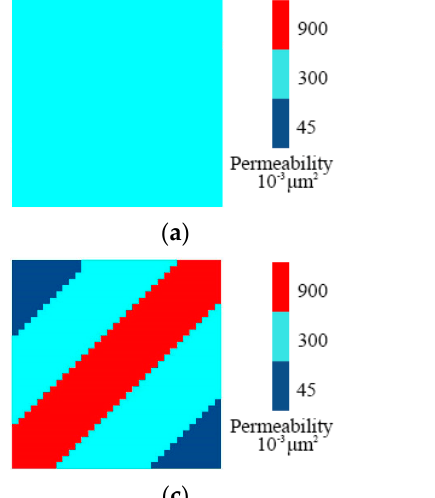
Figure 10. Permeability distribution of four single-layer synthetic models. ( a ) Homogeneous distri- bution; ( b ) vertical distribution; ( c ) diagonal distribution; ( d ) block-like distribution.